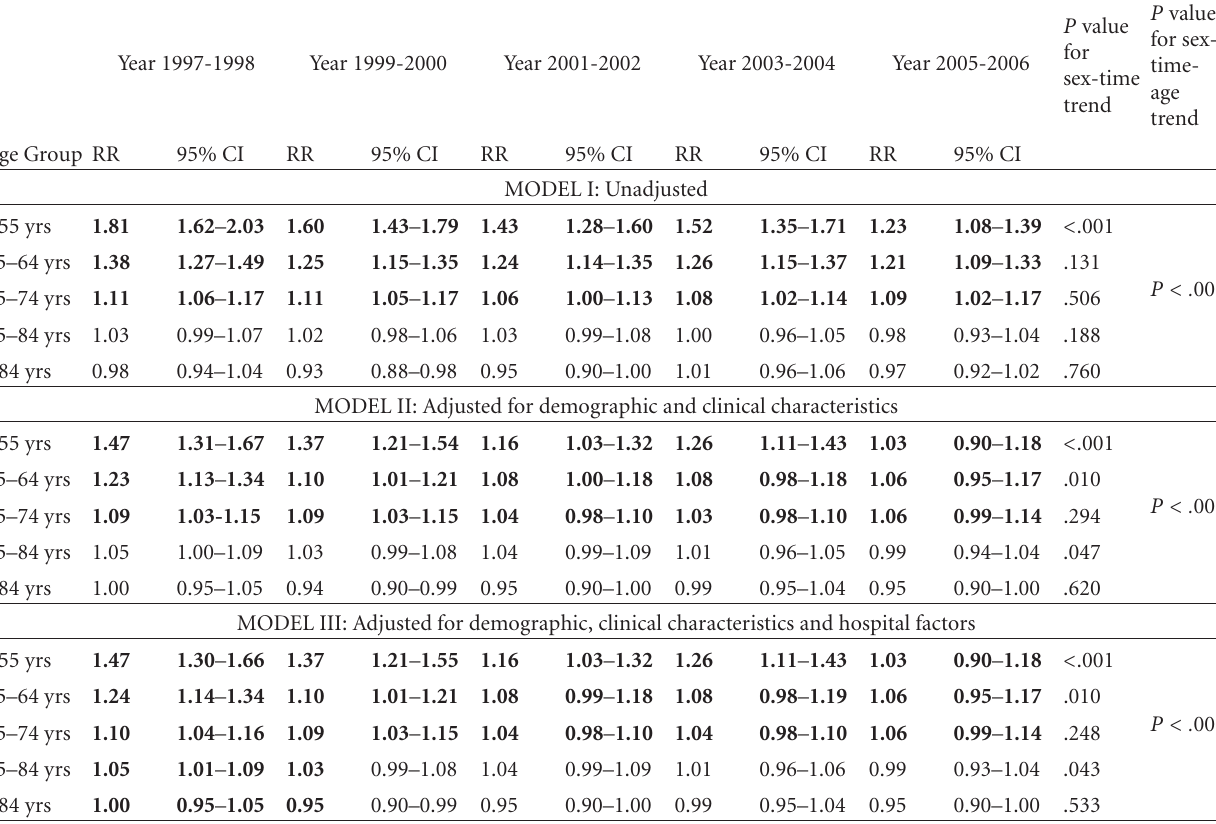
Table 5: Univariate (unadjusted) and multivariable (adjusted) Cox regression analysis models for in-hospital AMI mortality NIS year and age group: female versus male (male = reference).